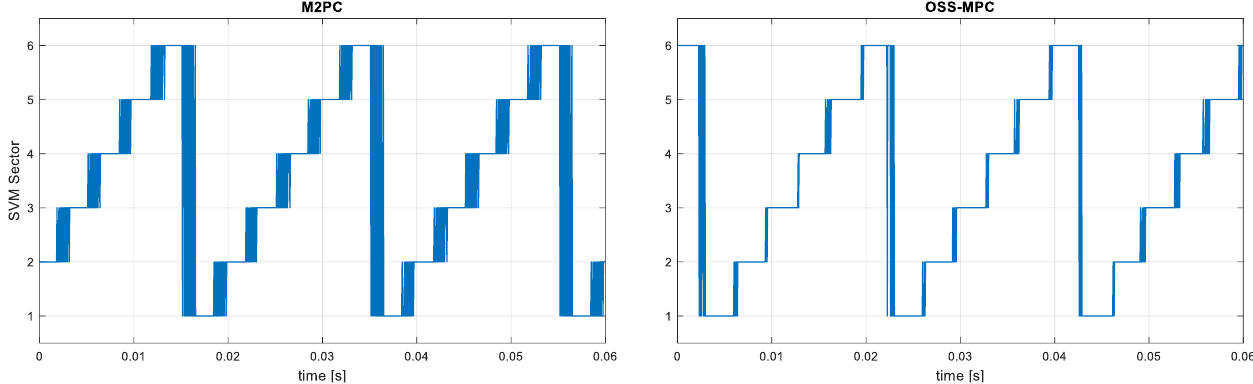
Figure 16. Comparison of phase a SVM sector selection for M2PC and OSS-MPC for 𝑃 ∗ = 4 kW, 𝑄 ∗ = 4 kVAr (obtained from CCS).